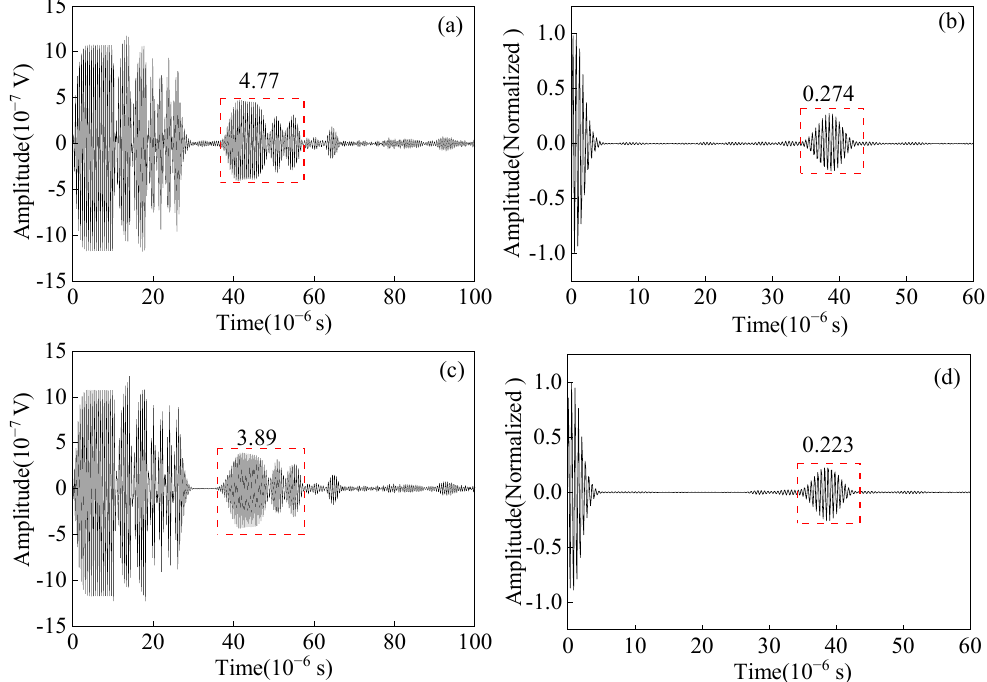
Figure 21. ( a ) Signal before pulse compression ( b ) pulse compressed signal with impedance matching method I; ( c ) signal before pulse compression ( d ) pulse compressed signal with impedance matching method II.